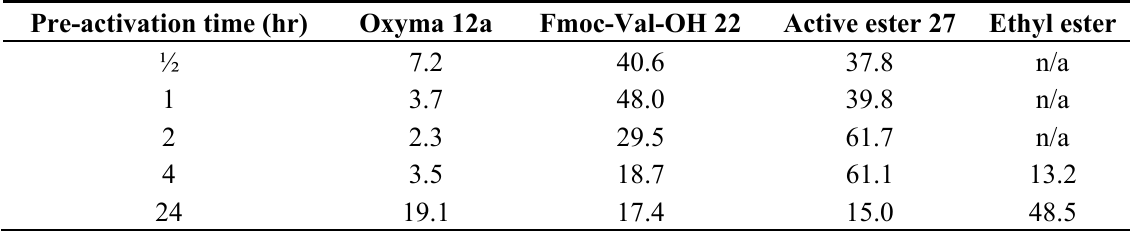
2-(ethoxycarbonyloxyimino)acetate ( 13a ).